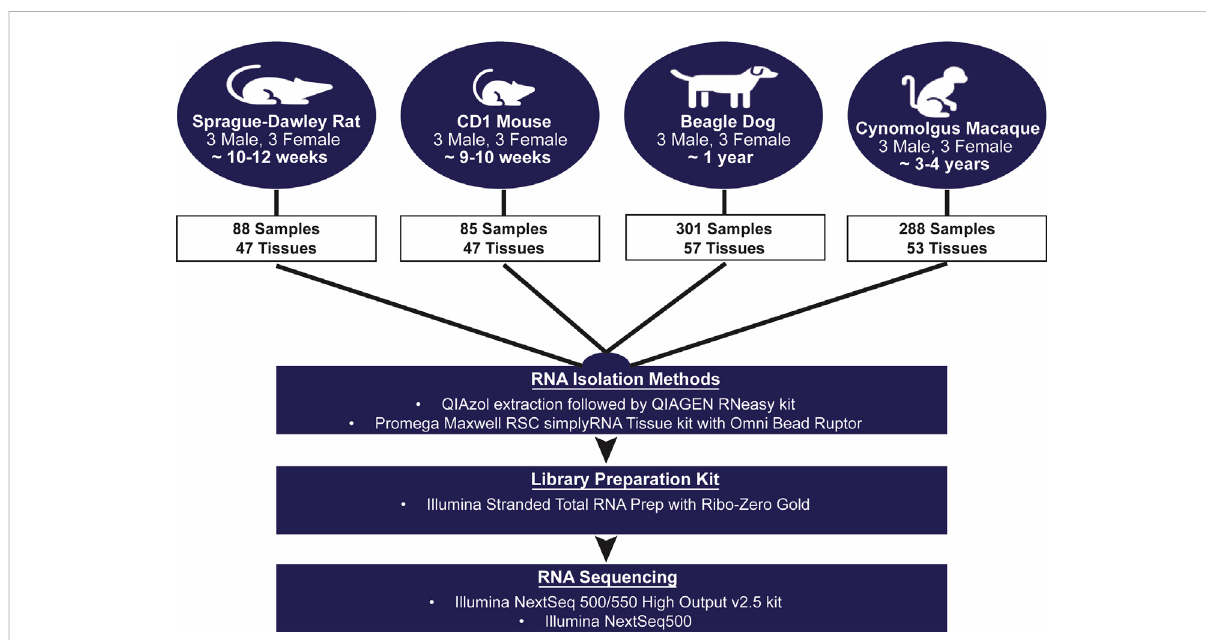
FIGURE 1 Transcriptomic Body Atlas Study Design. A large number of diverse tissues from mouse, rat, dog, and monkey in males and females were collectedseparatelyforRNAisolationandusedforRNA-Sequencingandgenerationofatranscriptomicbodyatlas.Foreachspecies,strainsandages matched those most commonly used in preclinical drug safety